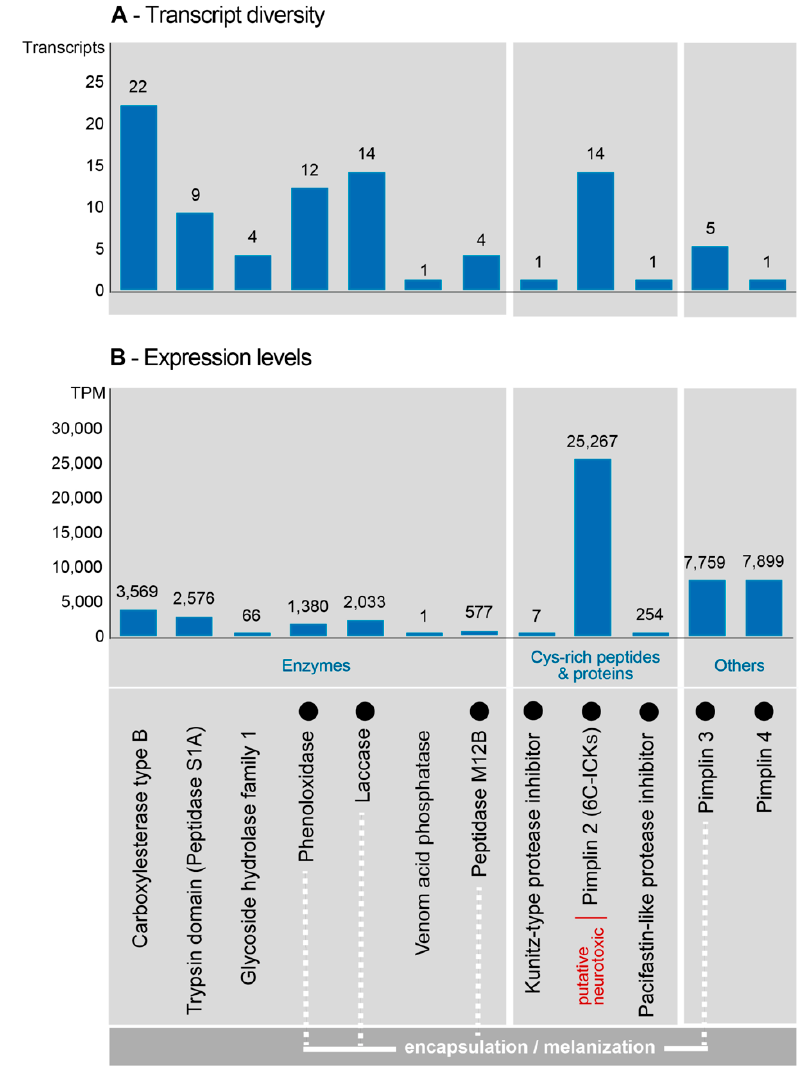
Figure 18. Transcript diversity and expression levels of identified known venom protein families (Source: from [57], reproduced under the terms of Creative Commons Attribution Licence CC-BY 4.0 via Toxins ).